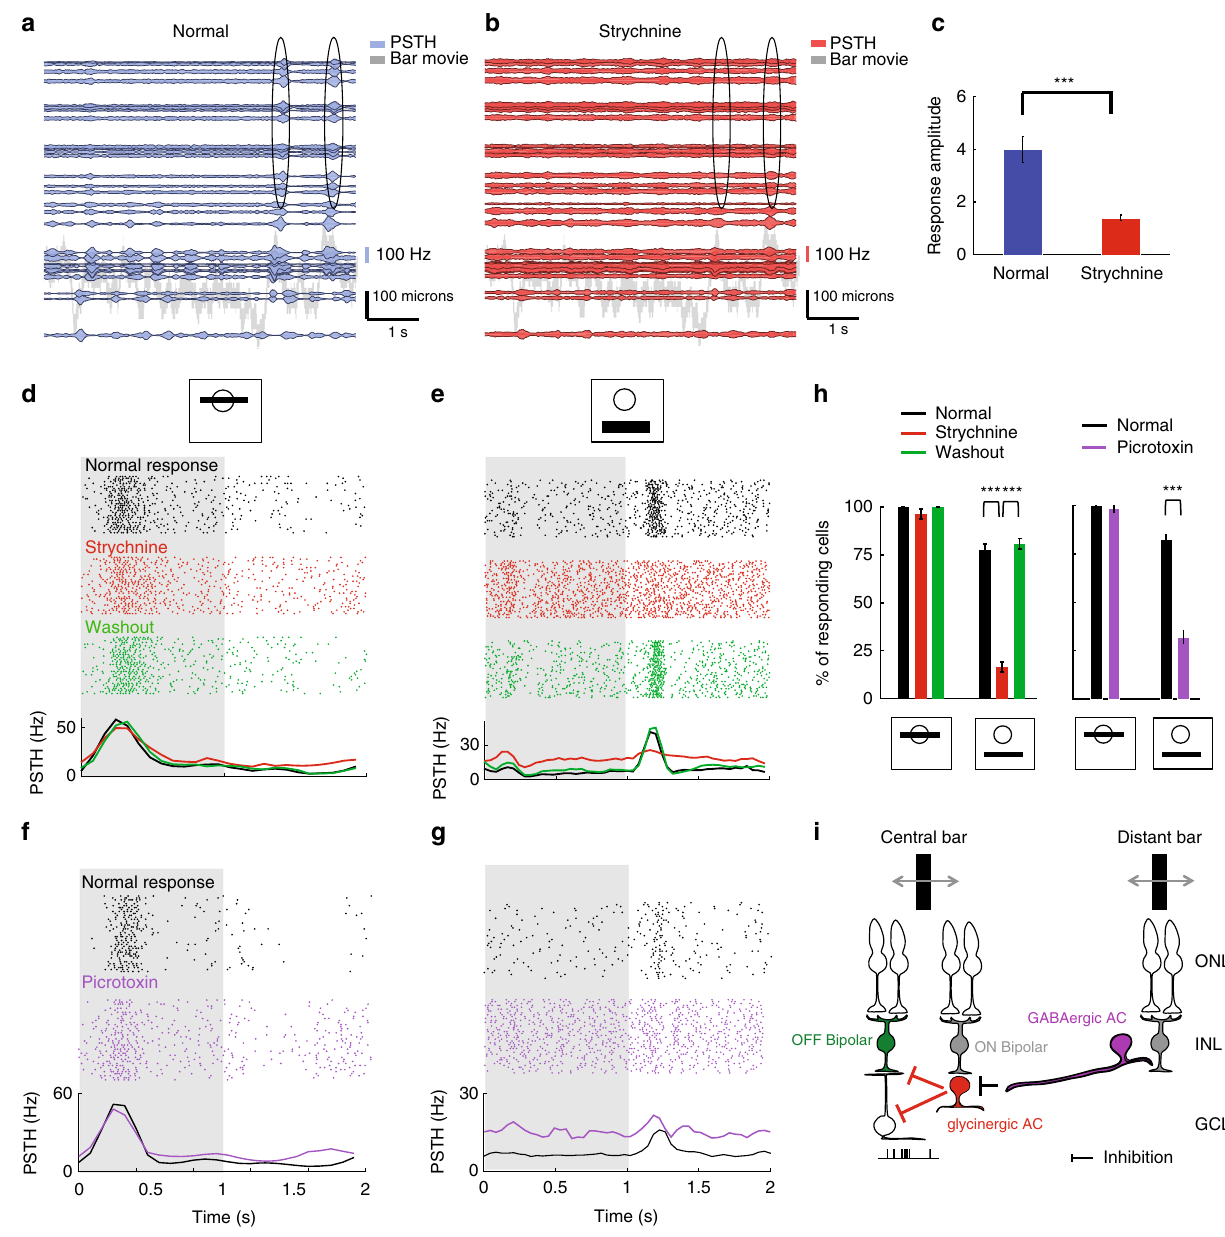
Fig. 7 A disinhibitory circuit of amacrine cells is responsible for distant activation. a Responses of ganglion cells to a randomly moving bar, similar representation than Fig. 1c. Ellipse indicates responses of distant cells. b Same as a after application of strychnine. c Distant response amplitude (see Methods section) for normal (blue) and strychnine (red) condition ( n = 16 cells). The three stars indicate that the p -value of a two-sample t -test was lower than 0.001. d Response to a bar fl ashed inside the receptive fi eld center is not altered by the addition of strychnine. Single-cell responses to repeated presentations of the dark bar (shaded gray indicates the time window where the bar was presented); each dot is a spike, each row corresponds to a stimulus repeat. Black: control. Red: after addition of 1 μ M strychnine to the bath. Green: after washing out strychnine. Bottom: PSTHs computed from the rasters. e Same as a for a bar fl ashed far from the receptive fi eld center. f Single-cell responses to repeated presentations of the dark bar, same representation as in d . Black raster: control. Purple raster: after addition of 10 μ M picrotoxin to the bath. Bottom: PSTHs computed from the rasters. g Same as f for a bar fl ashed far from the receptive fi eld center. h Left histogram: percentage of cells responding to a central fl ash (left) and to a distant fl ash (right) before and after strychnine application, and after the drug wash-out. Same colors as d , e . Data are represented as mean ± SEM. Right histogram: same for picrotoxin. The three stars indicate that the p -value of a two-sample t -test was lower than 0.001. i Schematic showing a putative circuit for distant activation. When a distant stimulus is present, excitation of GABAergic amacrine cells (blue), through ON bipolar cells, inhibits subsequent glycinergic amacrine cells (red), which, in turn, disinhibits bipolar cells and ganglion cells. Similar glycinergic cells relay the output of ON bipolar cell inside the receptive fi eld center to create a balance between ON and OFF inputs (see text). ONL: outer nuclear layer. INL: inner nuclear layer. GCL: ganglion cell